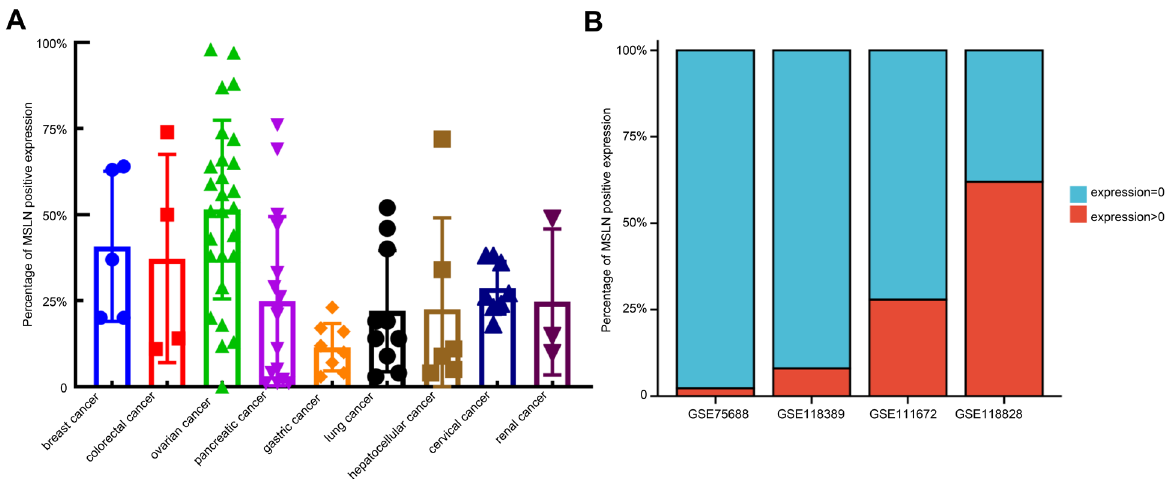
Figure 4. Heterogeneous expression of MSLN in solid tumors. ( A ) Calculation of the expression rate of MSLN in malignant cells of different solid tumors at the protein level with ImageJ. The percentage of MSLN-positive tumor cells among the total number of tumor cells was calculated by IHC. The result of IHC verified by two pathologists. ( B ) Calculation of the expression rate of MSLN in malignant cells of triple-negative breast cancer (GSE75688 and GSE118389), pancreatic cancer (GSE111672) and ovarian cancer (GSE118828) using single-cell sequencing data downloaded from the GEO database (https://www.ncbi.nlm.nih.gov/geo/ (accessed on 28 September 2022)). The percentage of tumor cells with MSLN expression > 0 of the total number of tumor cells in the single-cell data was calculated.